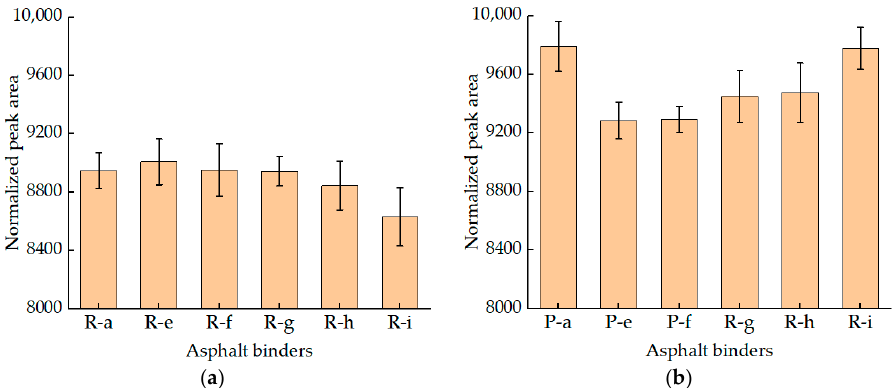
Figure 9. The NPA of aged CRM asphalt binders. ( a ) The NPA of RTFOT CRM asphalt binder; ( b ) The NPA of PAV CRM asphalt binders.